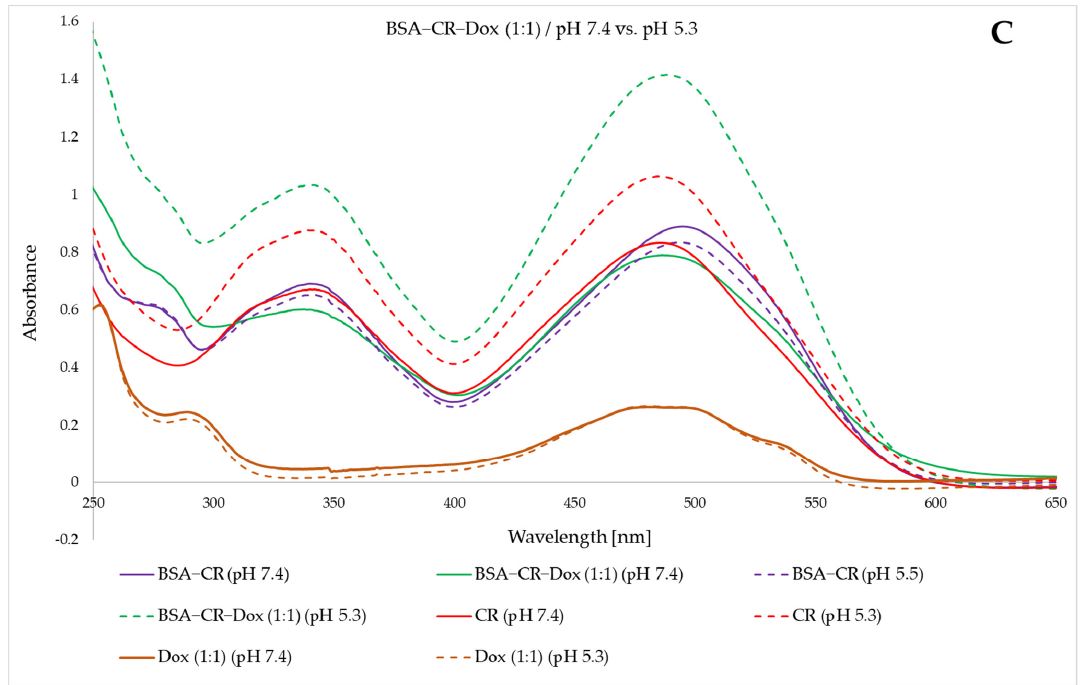
Figure 11. The effect of the breakdown of BSA–CR–Dox complexes (analyzed 3 molar proportions of CR–Dox) accompanying the changes of pH from 7.4 to 5.3. The spectra of the complexes at pH 5.3 are marked with dashed lines. The spectra of the complexes at pH 7.4 are marked with solid lines. ( A ) spectra of the BSA–CR–Dox complex (for a 5:1 molar ratio of CR–Dox); ( B ) spectra of the BSA–CR–Dox complex (for a 2:1 CR–Dox molar ratio); ( C ) spectra of the BSA–CR–Dox complex (for the molar ratio of CR–Dox 1:1).